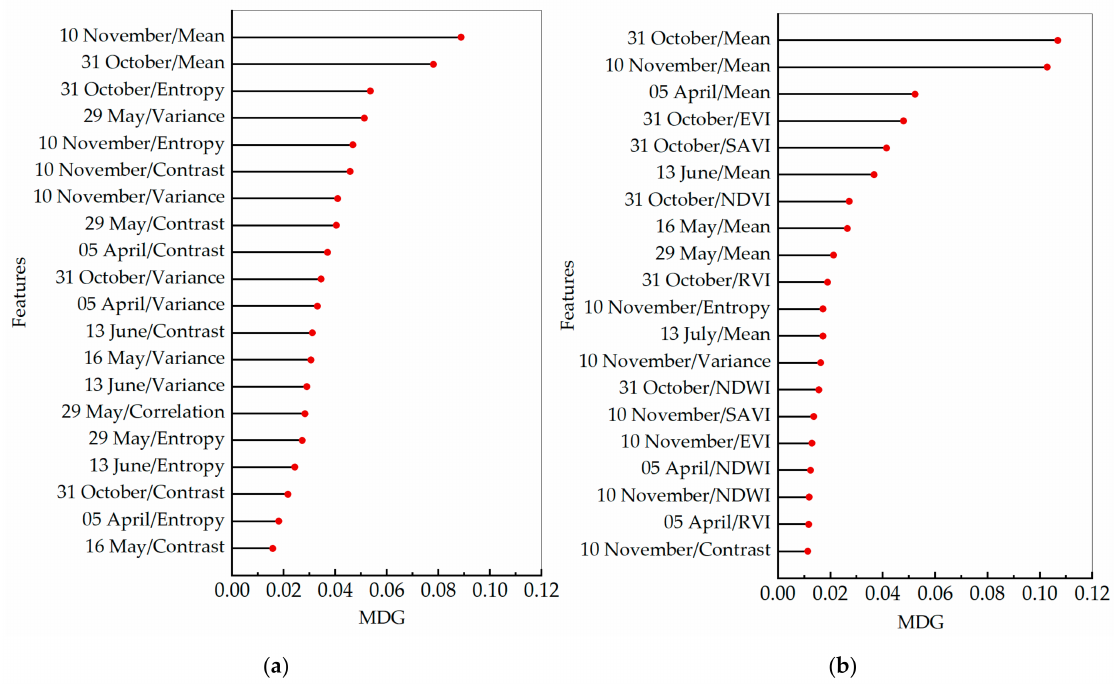
Figure 7. The top 20 important features according to Mean Decrease in Gini. ( a ) Model 1 and ( b ) Model 2.